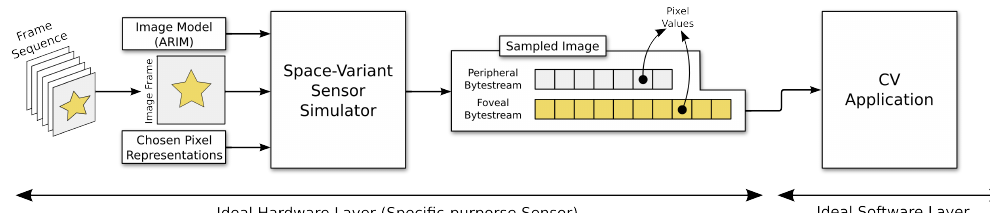
Figure 7. Implemented workflow for simulating the use of ARIMs in a specific Computer Vision (CV) application. In an ideal scenario, the ARIM, a captured image frame, and the chosen pixel representations for foveal and periphery areas are input to an hypothetical specific-purpose sensor that changes its configuration at run-time. Such a sensor would yield a stream (bytestream) of pixel data from each region of the captured image. The stream (not the 2D image) would be forwarded to the CV application. However, for simulation purposes, this architecture is fully implemented by software.